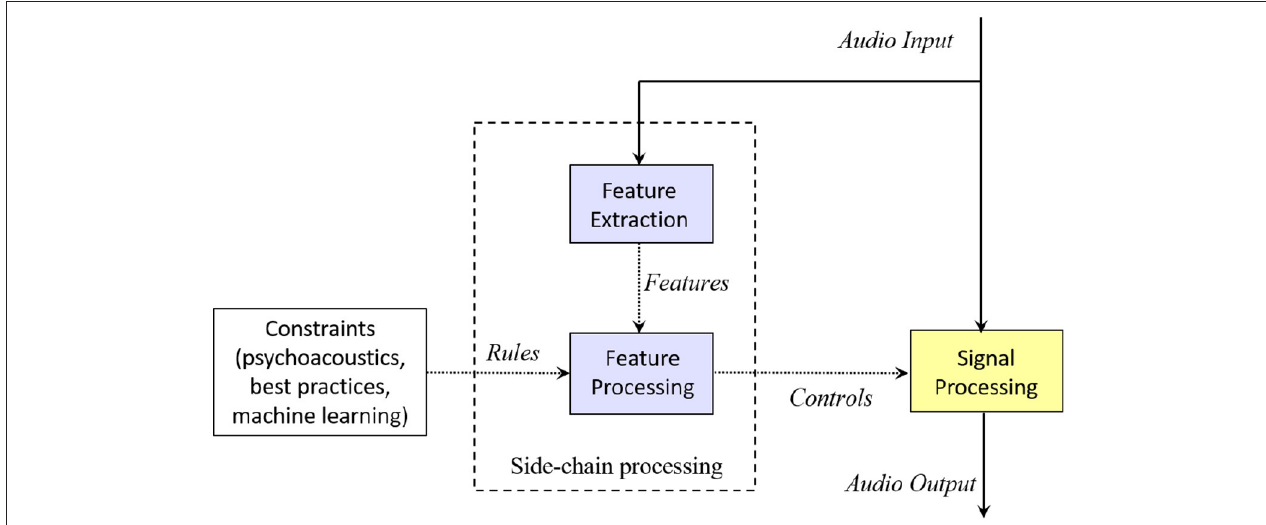
FIGURE 3 | An intelligent audio effect. Features of the input audio signal are extracted and analyzed to produce controls. The control values are often based on rules intended to mimic the behavior of a trained engineer.